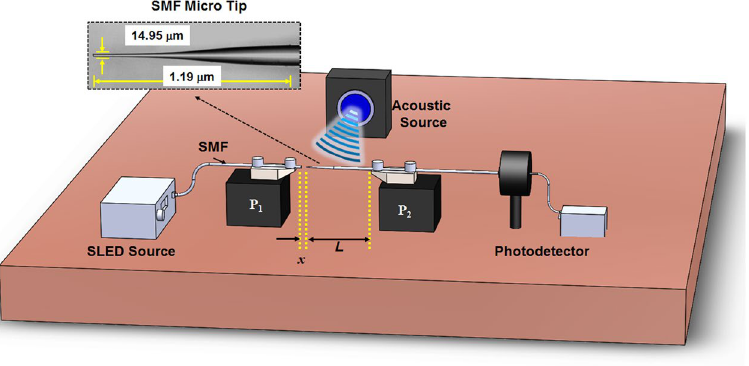
Figure 1. Schematic of micro-tip cantilever based optical fiber microphone; Inset shows the microscopic image of the SMF micro-tip.